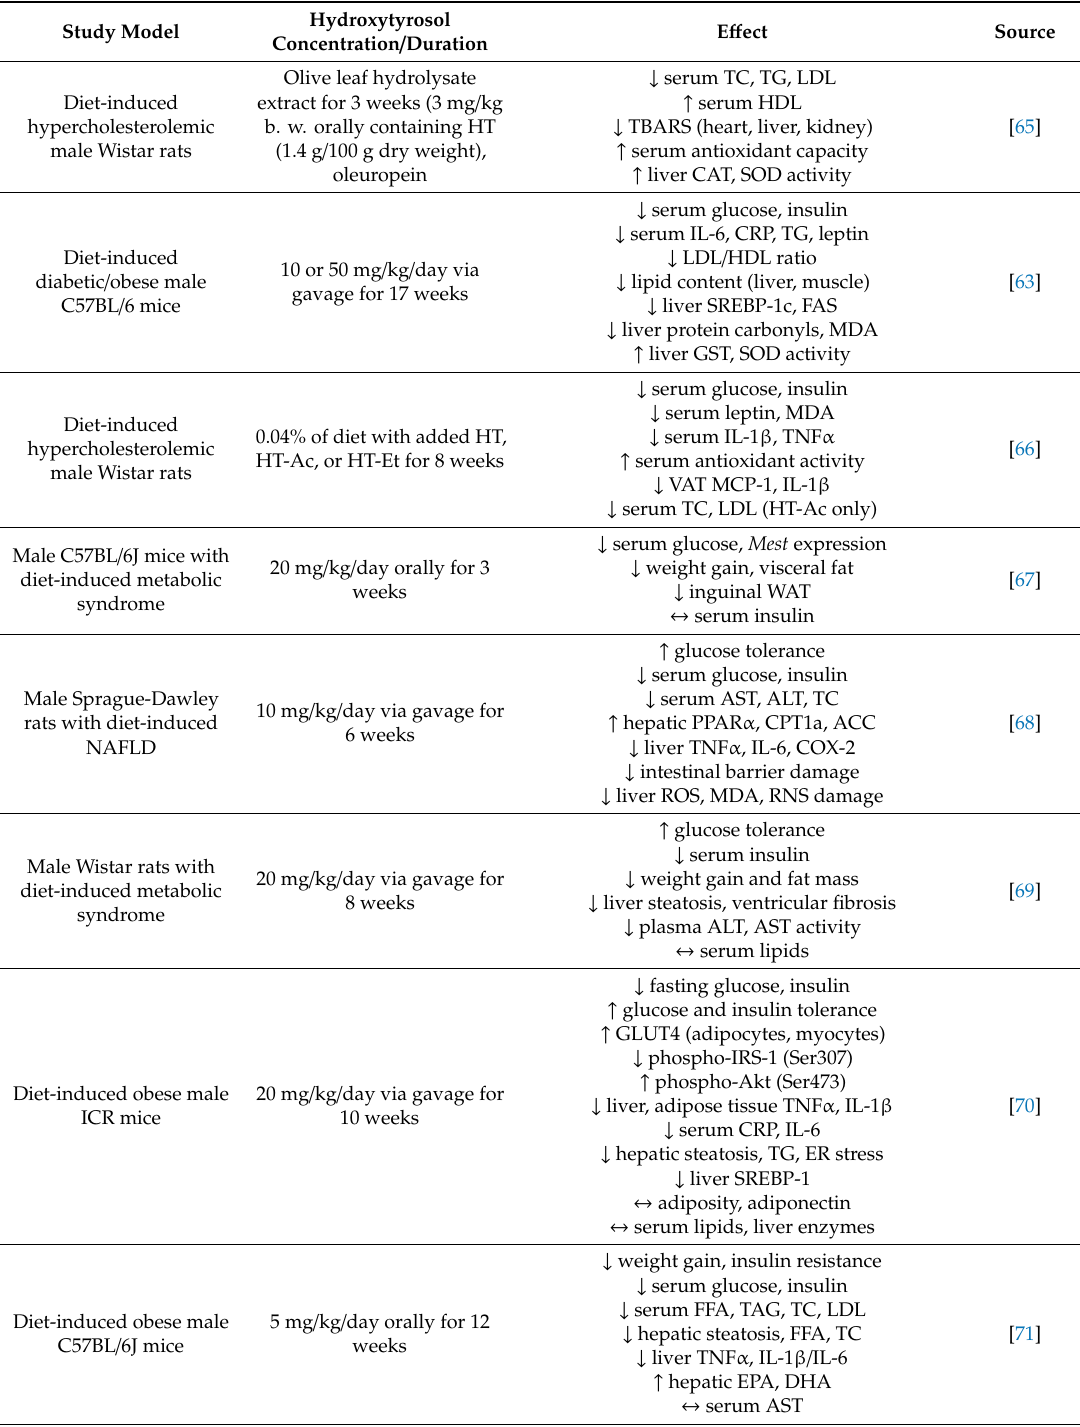
Table 8. Anti-diabetic E ff ects of Hydroxytyrosol: In vivo high-fat diet (HFD)-induced diabetes animal